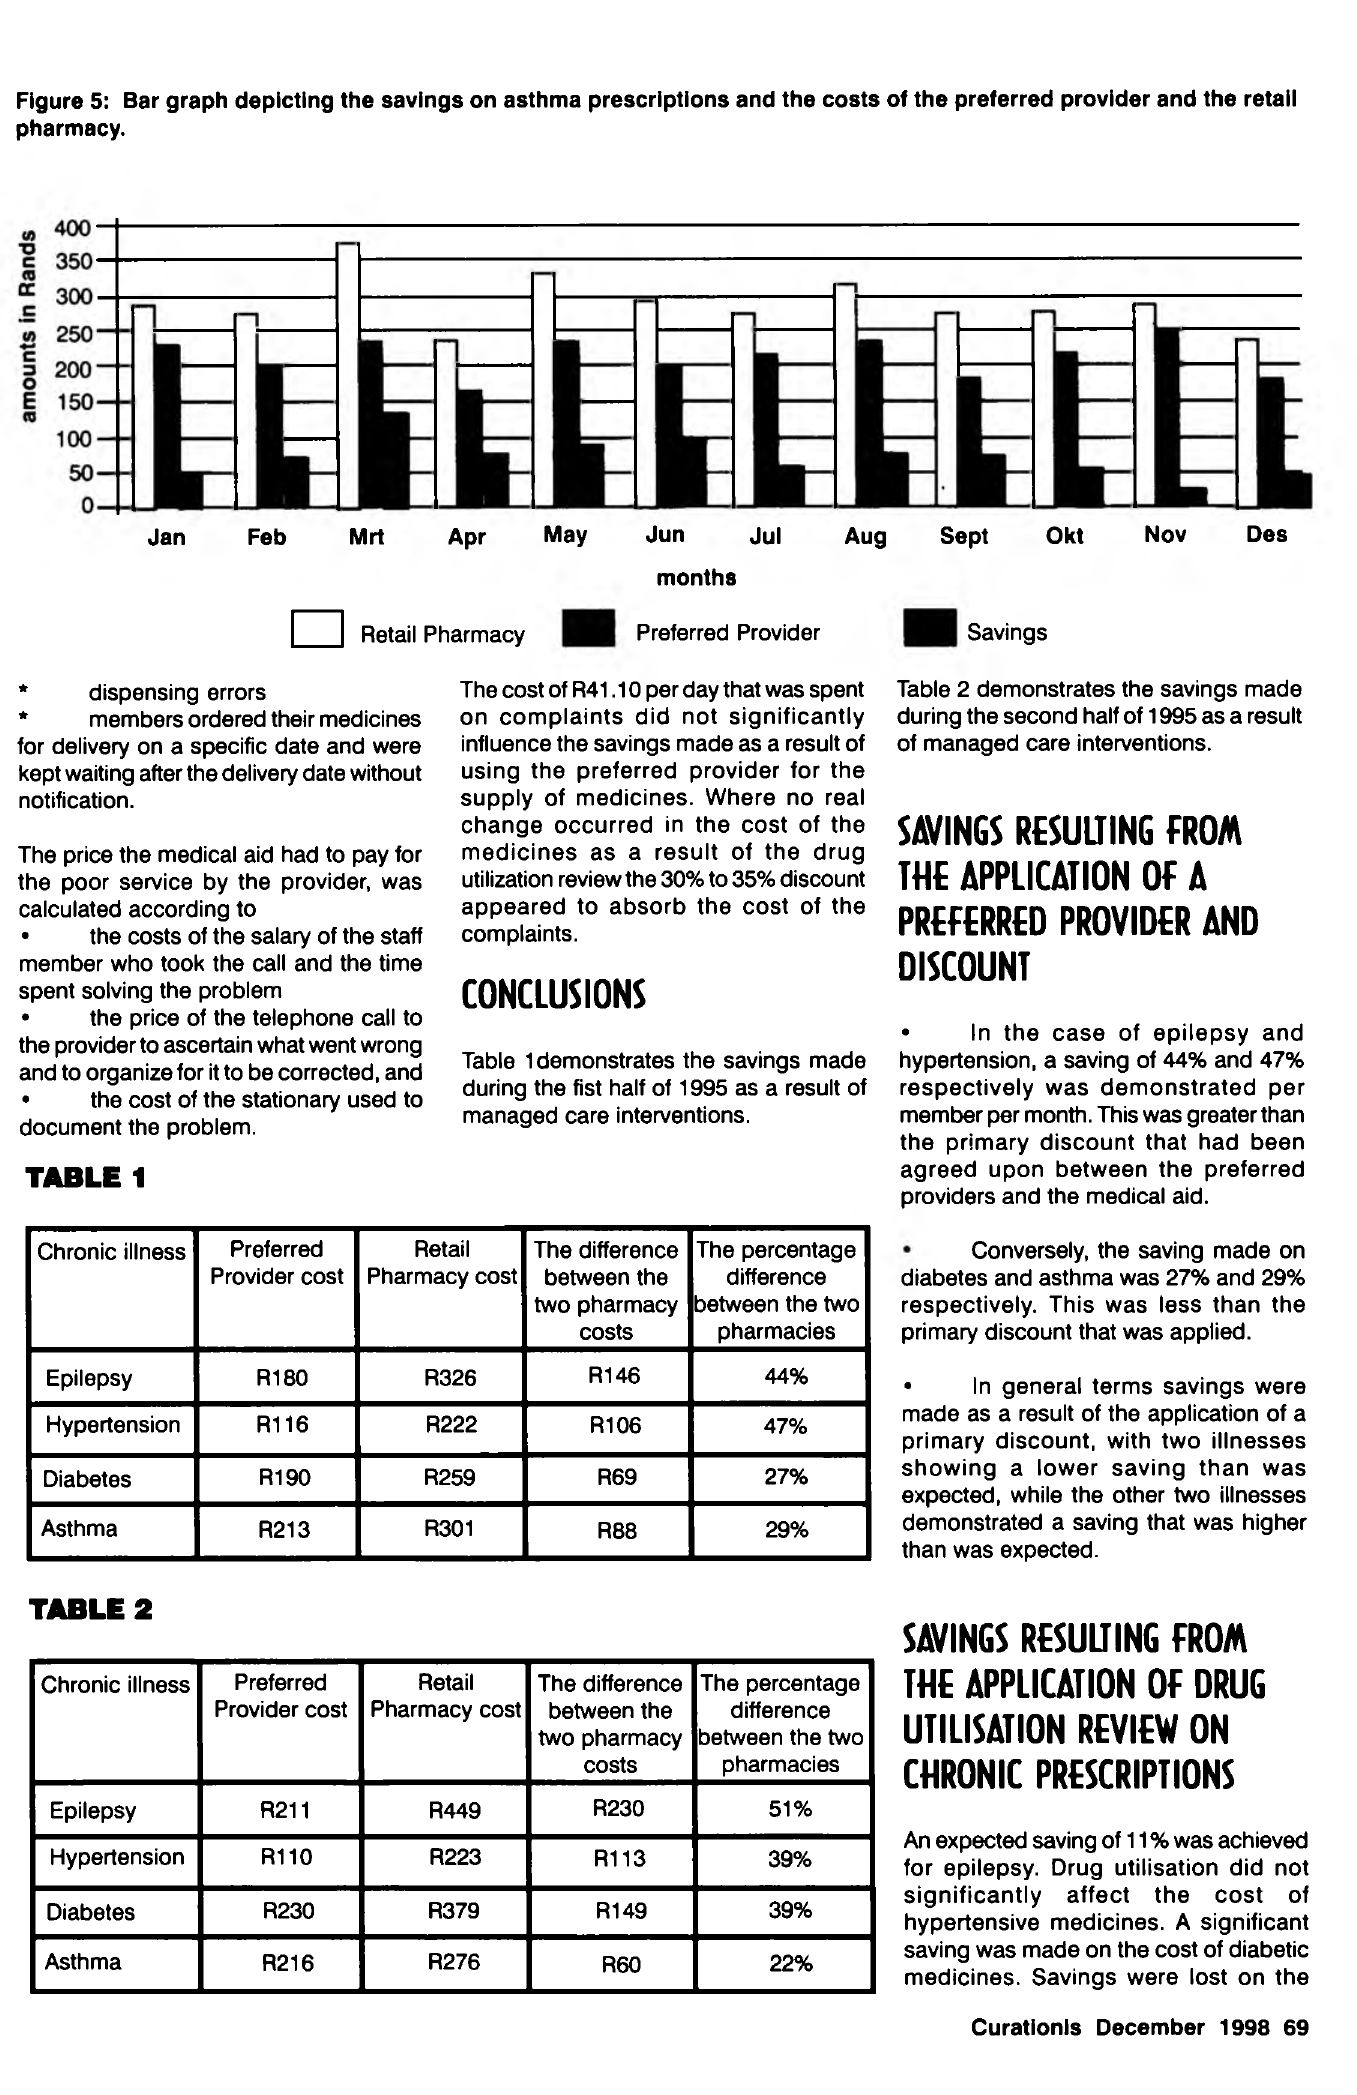
Figure 5: Bar graph depicting the savings on asthma prescriptions and the costs of the preferred provider and the retail pharmacy.